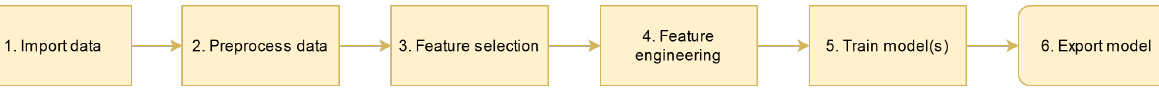
Figure 2. Ship classification model